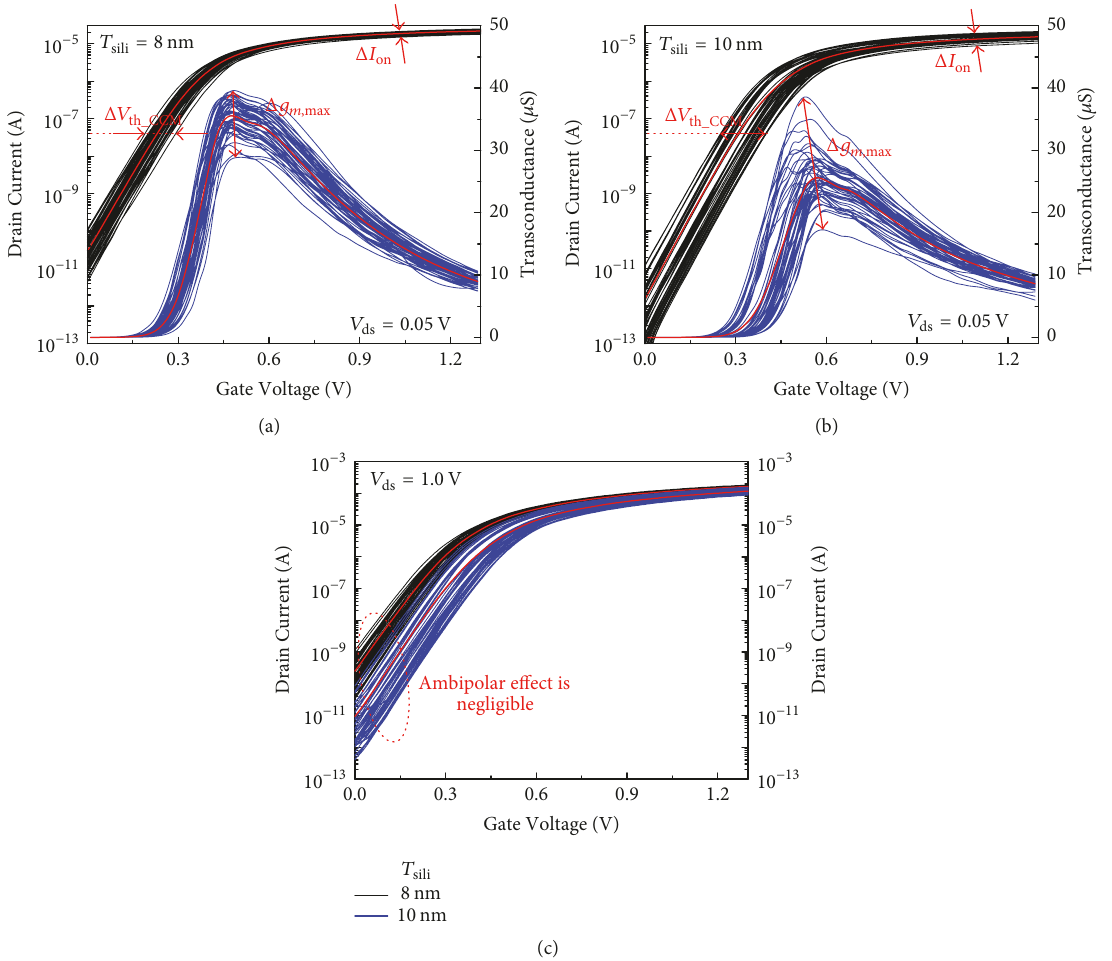
Figure 2: DC performance and variations of the SOI FinFETs with the 𝑇 The number of measured devices is 50 for each 𝑇